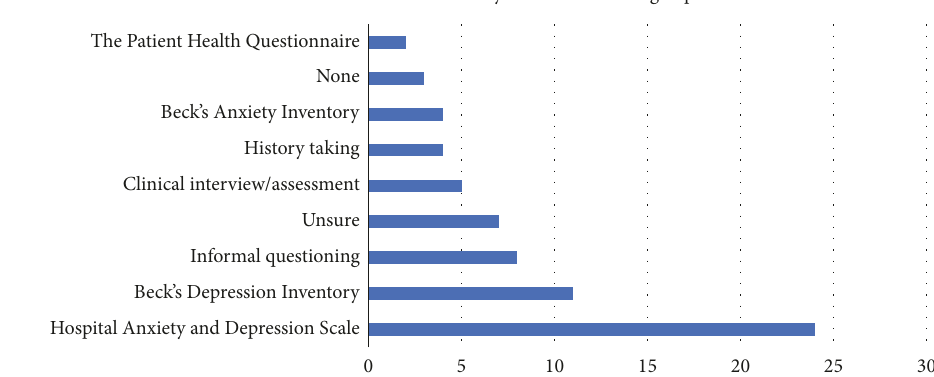
Figure 5: Mood screening tools/approaches listed by healthcare